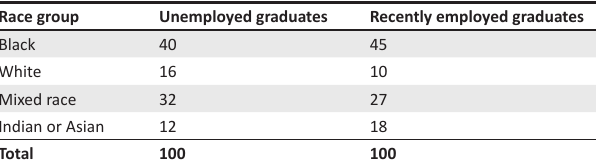
TABLE 1: Race distribution of sample ( % ).